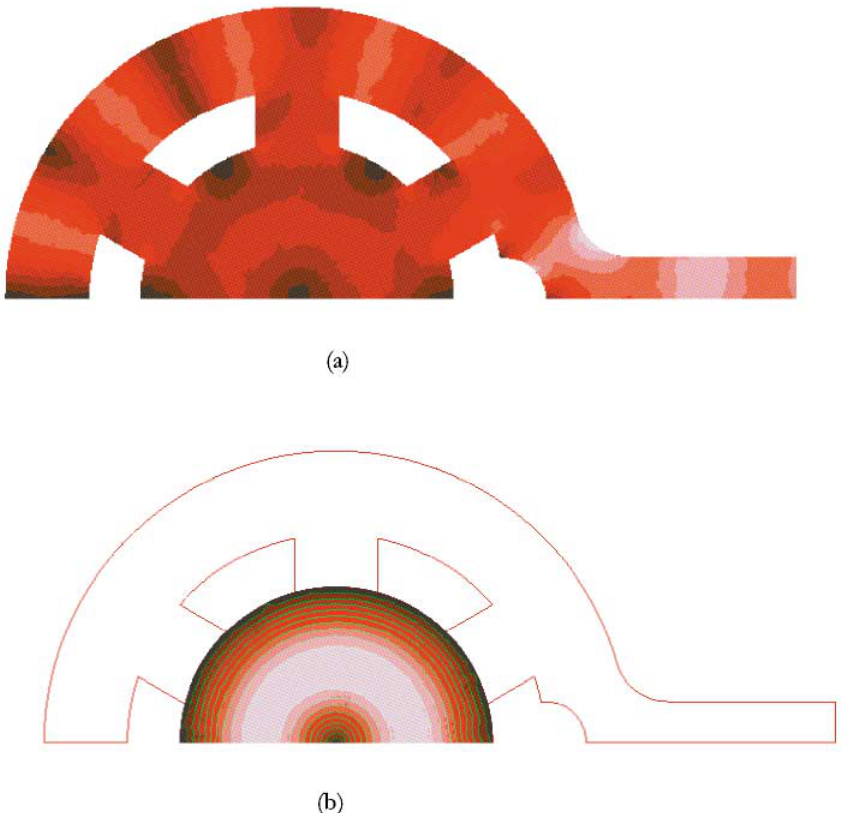
FIG. 13. (Color) HFSS simulation results for the wrap-around converter. The color shades represent the magnitude of the electrical field at (a) a cut plane through the slots and (b) a cut plane in the circular guide 2.5 cm away from the slots.